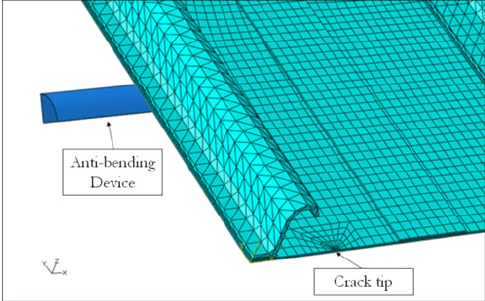
Figure 12: Representation of the anti-bending device developed in the FE modeling of panel 4-NB (No Bending). Model ID